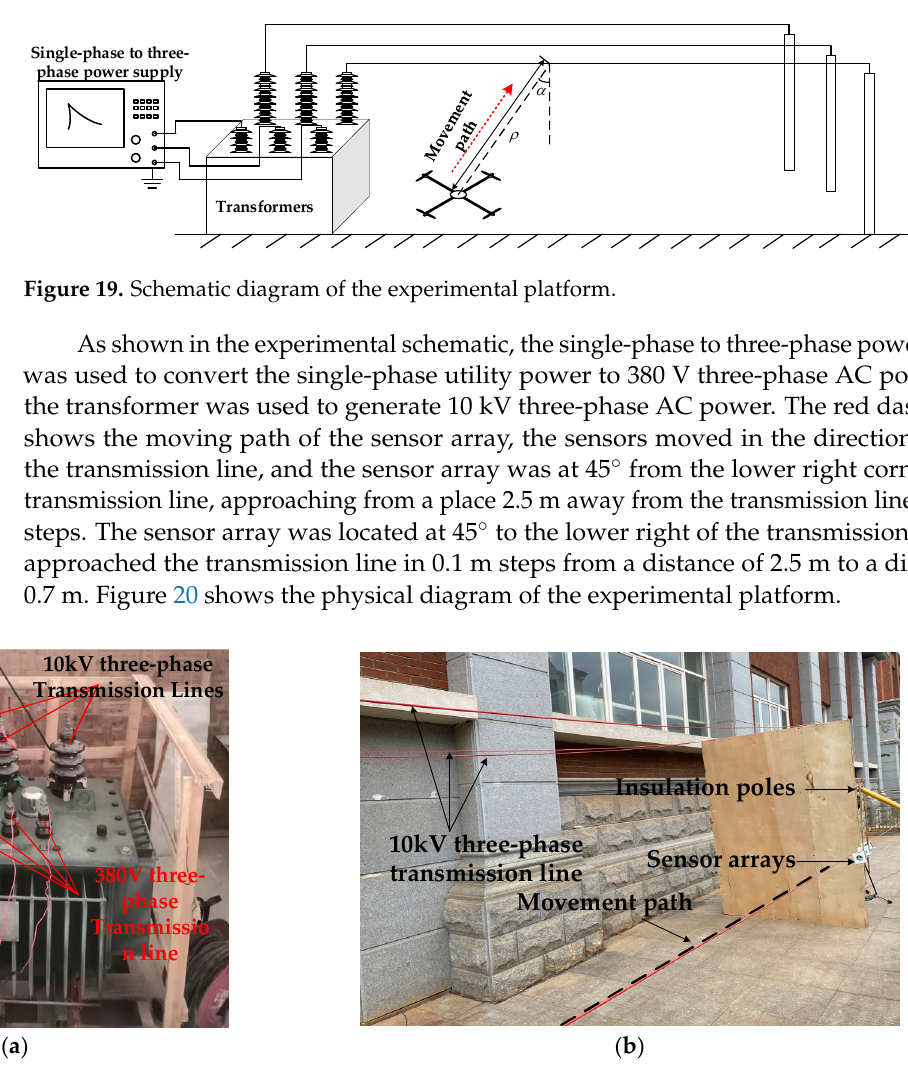
Figure 20. Physical diagram of the experimental platform. ( a ) 10 kV transformer; ( b ) physical view of transmission lines and